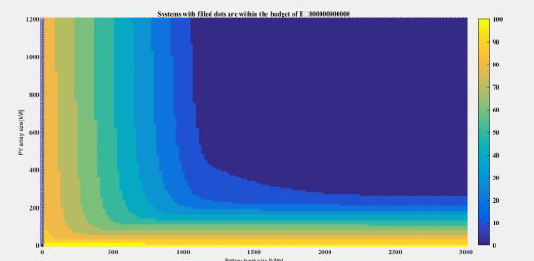
Figure 19. Budget for each LLP of the system